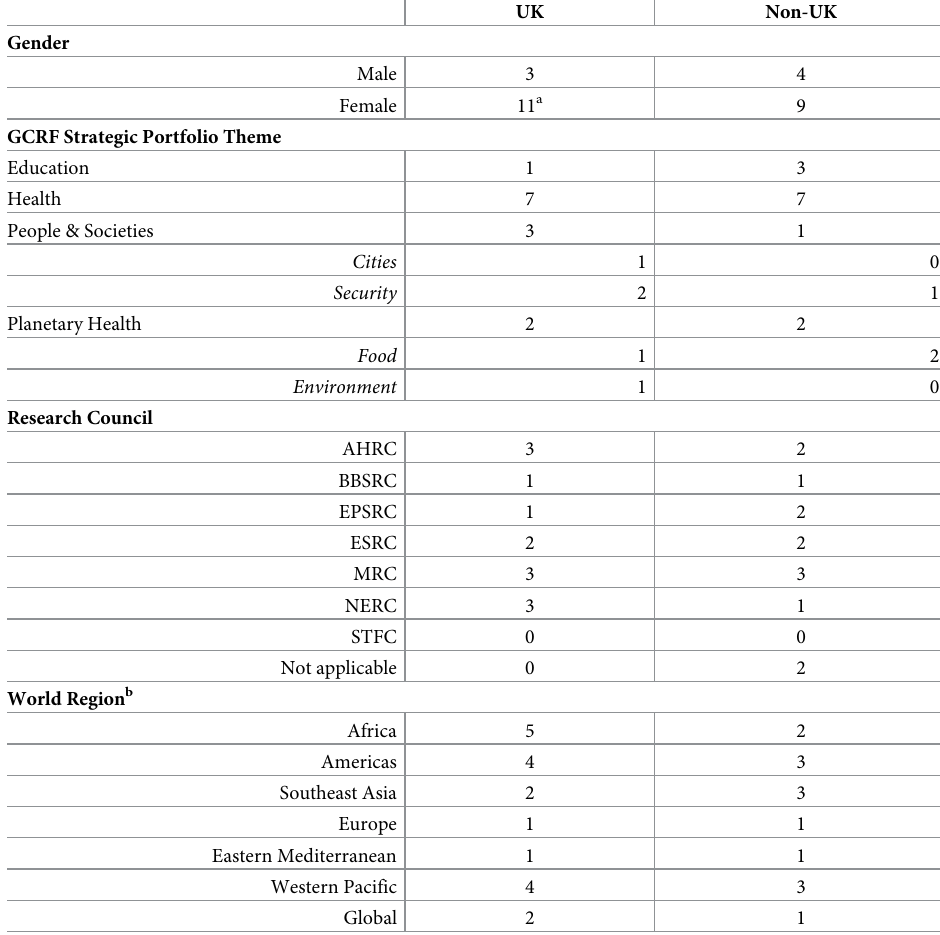
Table 2. Interviews by gender, GCRF strategic portfolio, research council, and world